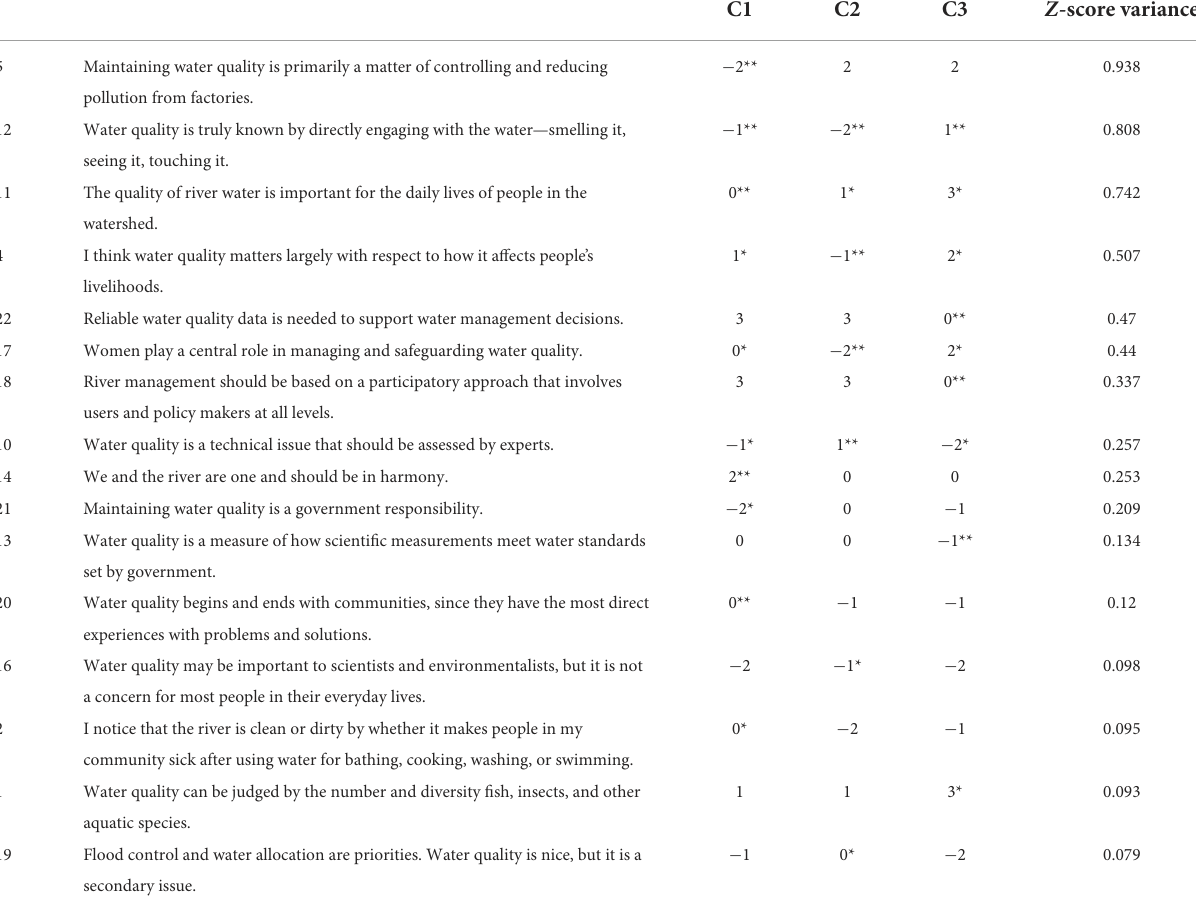
TABLE 6 Q1 Concept distinguishing statements in order of highest to lowest z -score